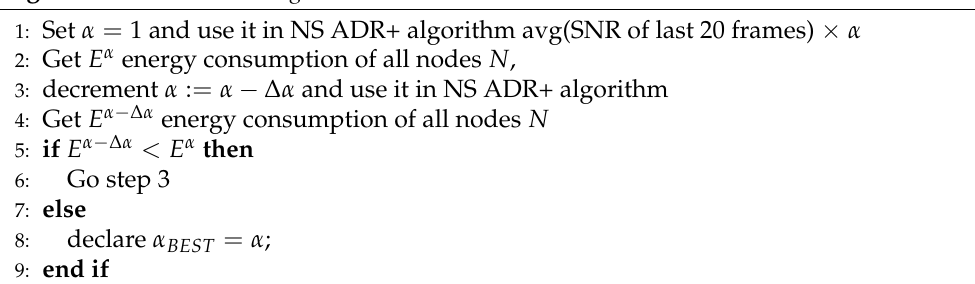
Algorithm 2 NS ADR++ algorithm